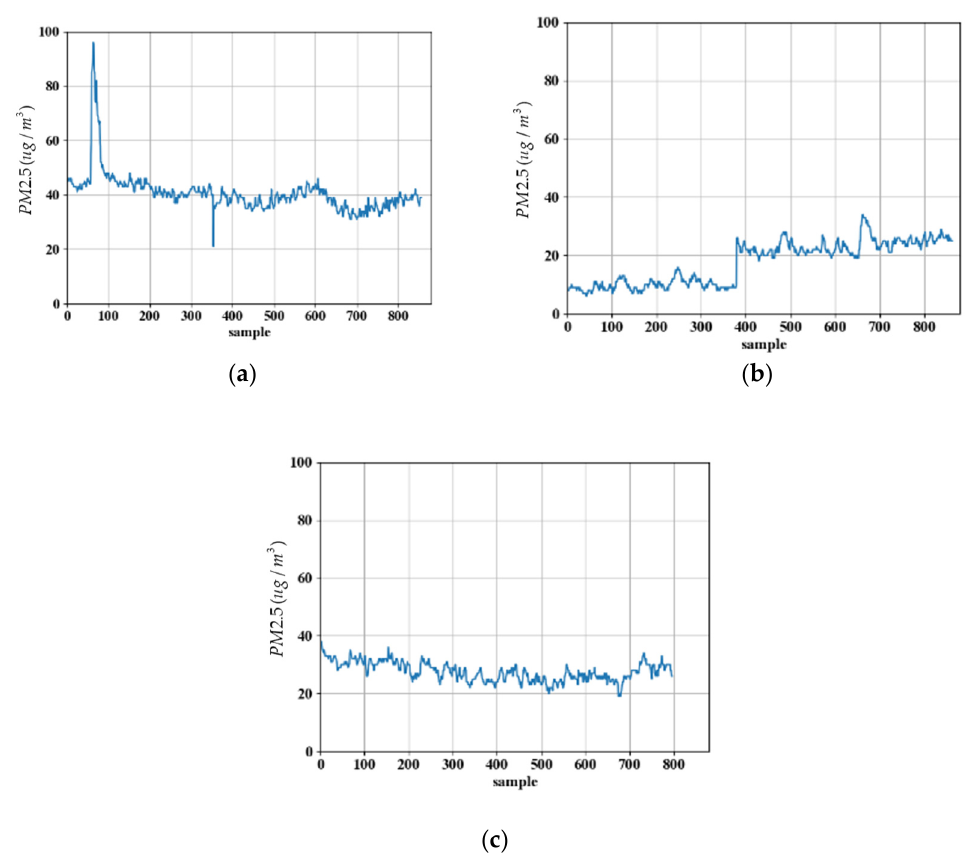
Figure 17. Measured pollutant concentration data: measured values at ( a ) 07:30 P.M. on 15 February 2019; ( b ) 02:00 and 06:00 P.M. on 28 February 2019; and ( c ) 04:30 P.M. on 1 March 2019.